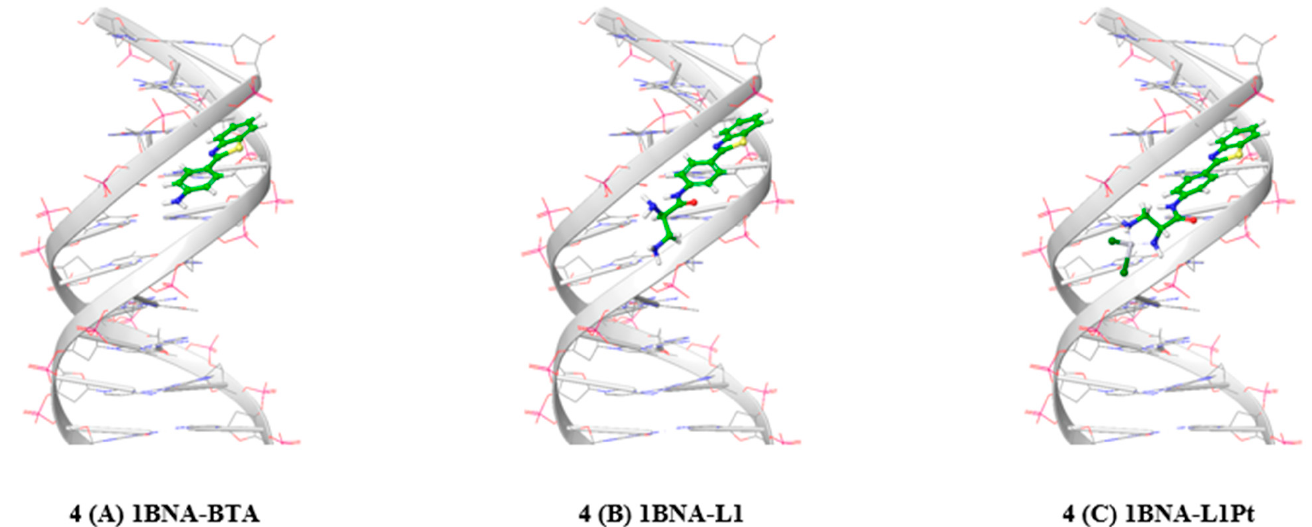
Figure 4. ( A ) Predicted binding pose of BTA on DNA (PDB ID: 1BNA). ( B ) Molecular docking simulation studies of the interaction between L1 and DNA (PDB ID: 1BNA). ( C ) Molecular docking simulation studies of the interaction between L1Pt and DNA (PDB ID: 1BNA).